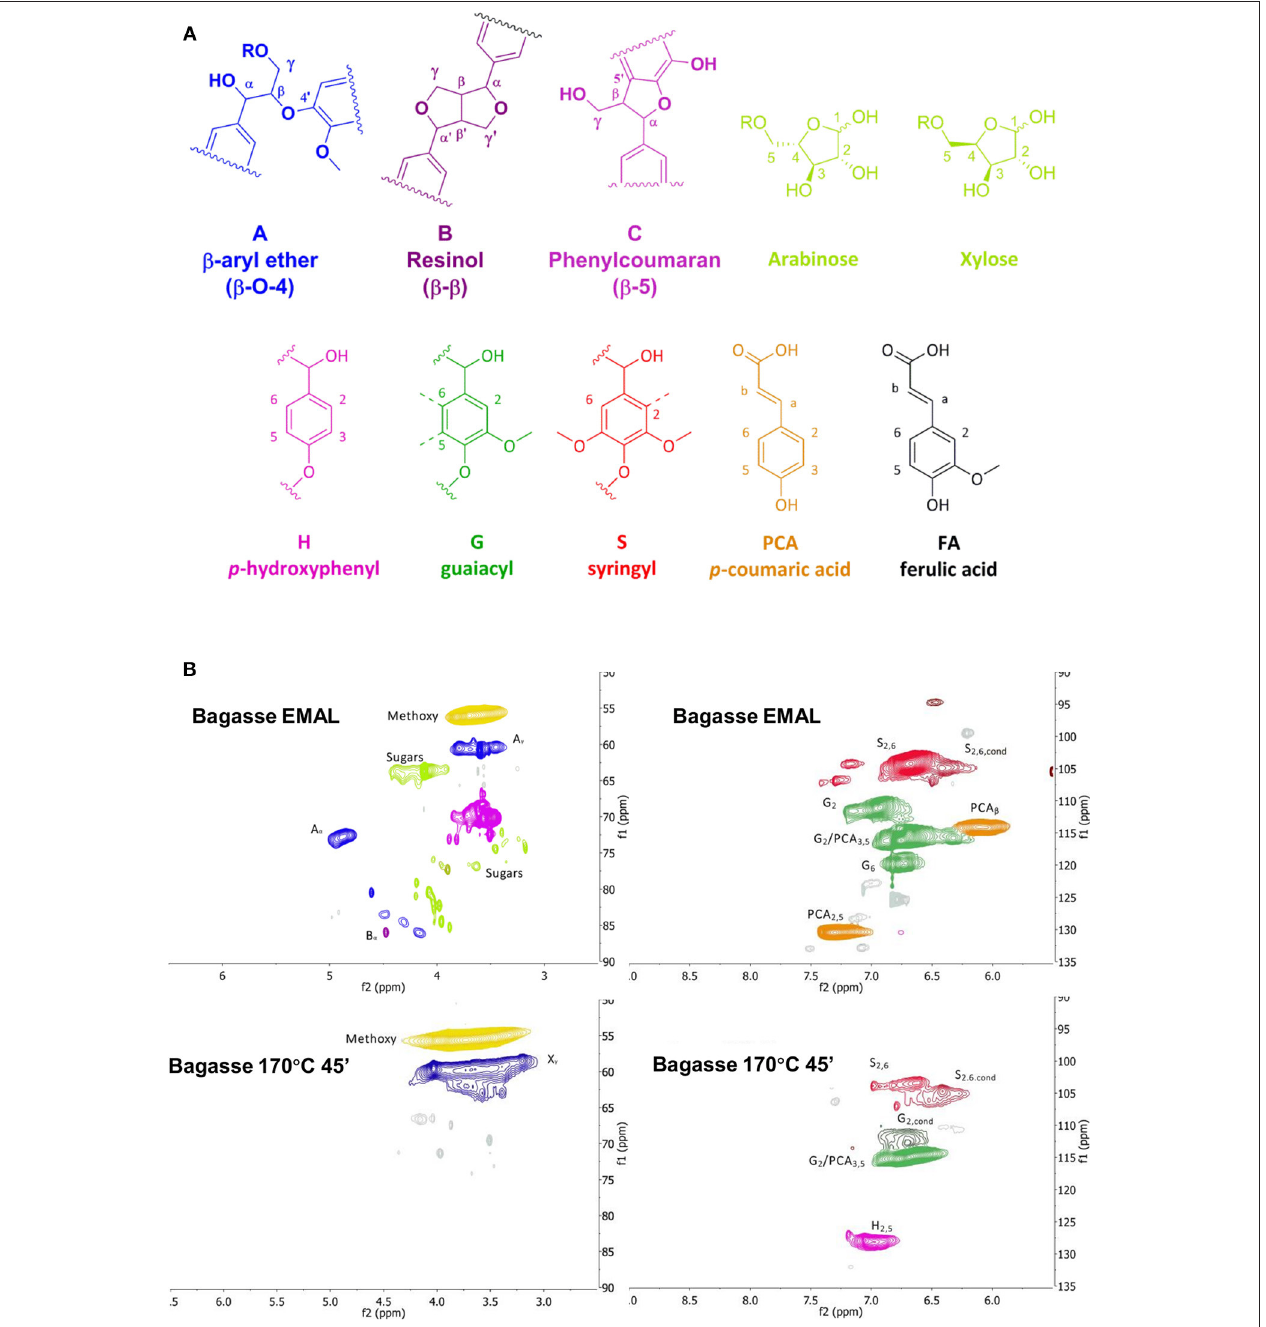
FIGURE 3 | (A) Lignin substructures found in grassy lignins, and (B) HSQC NMR spectra of bagasse enzymatic mild acidolysis lignin and lignin isolated with [TEA][HSO 4 ], with a water content of 20 wt% and a biomass to solvent ratio of 1:10 g/g. Side chain region (left) and aromatic region (right).